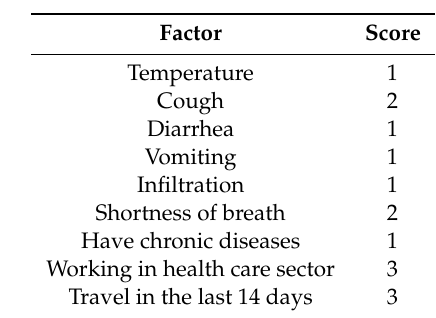
Figure 6. Main functions of mobile app. Table 2. Initial COVID